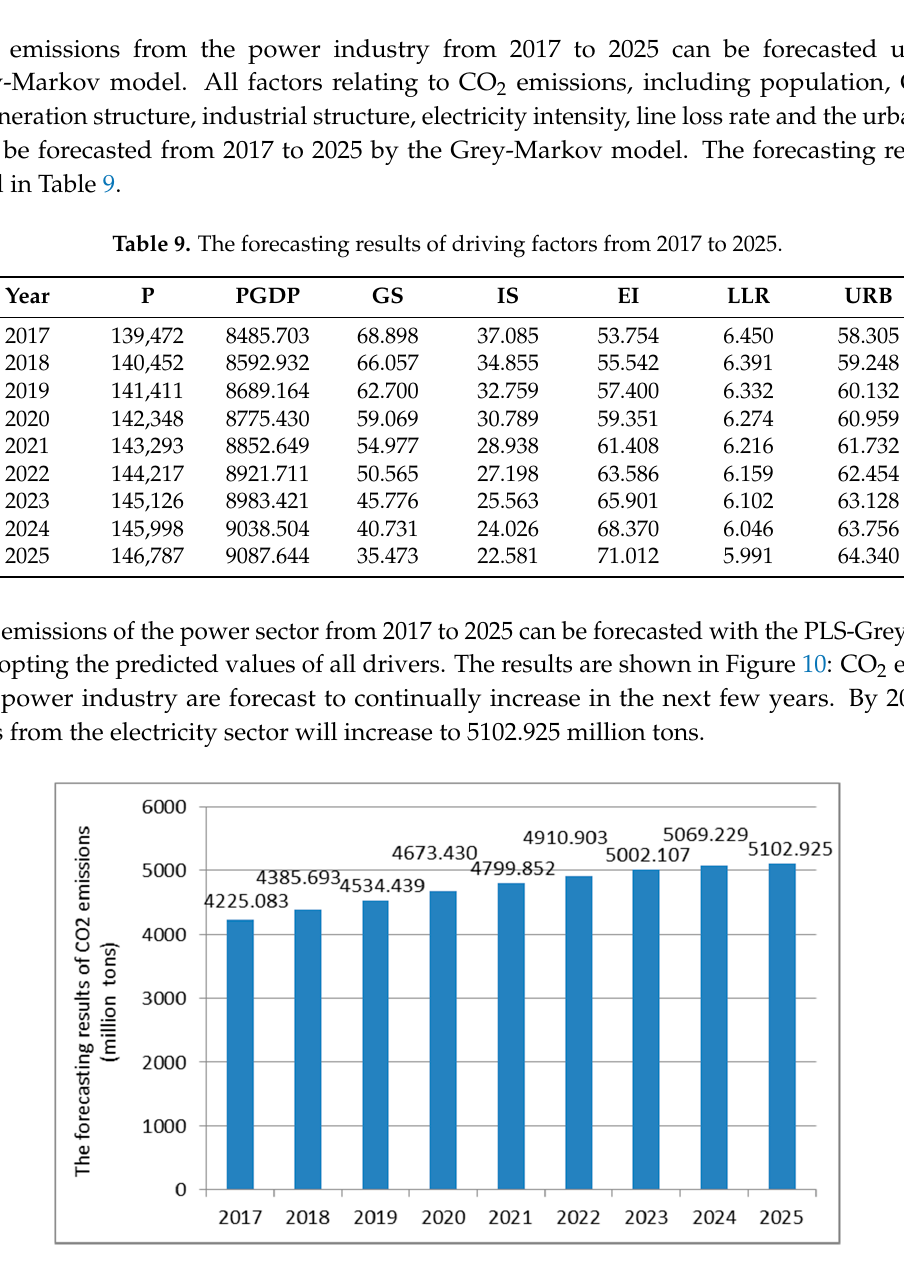
Figure 10. The forecasting result of CO 2 emissions in the power generation sector from 2017 to